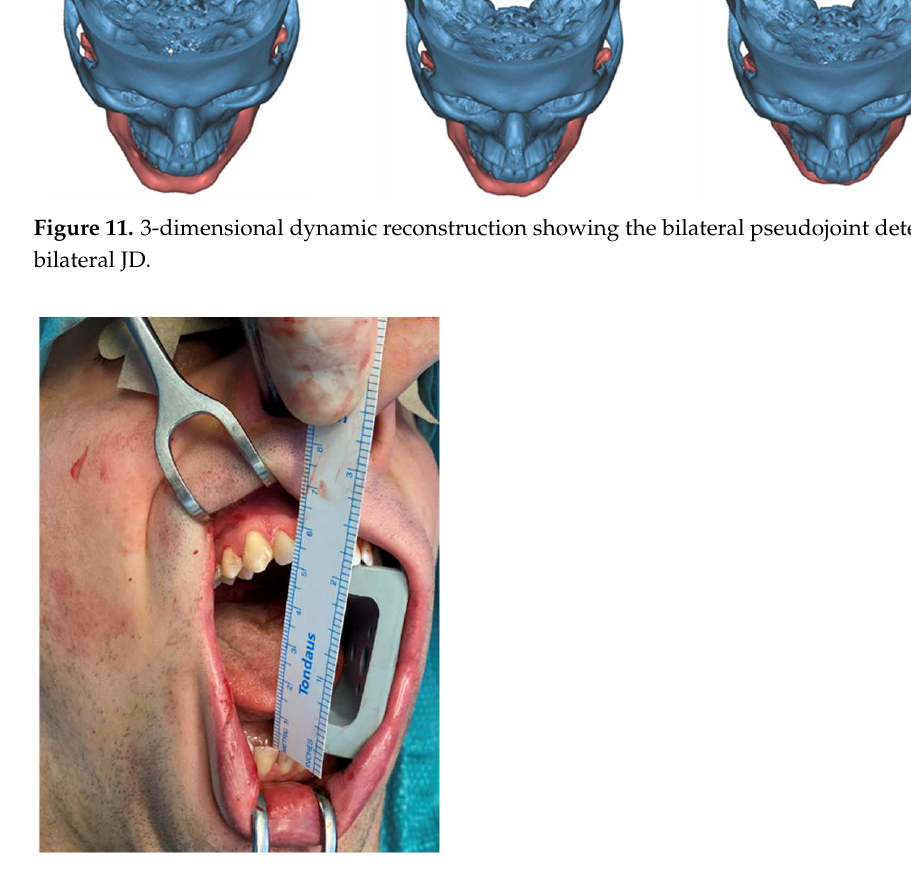
Figure 12. MMO of 50 mm right after bilateral coronoidectomy.